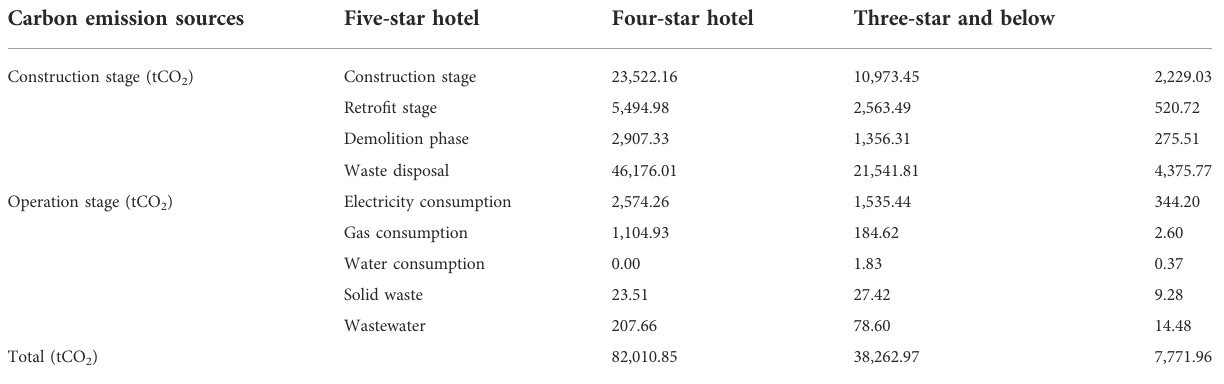
TABLE 5 Carbon emissions in each link of a single traditional